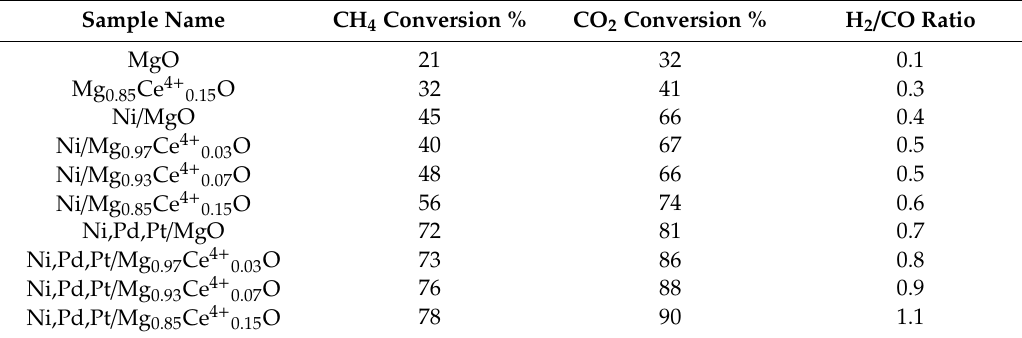
Table 4. The DRM reaction results of the catalysts at 900 ◦ C and a CH 4 :CO 2 ratio of 1:1 ratio with GHSV = 15,000 mL h − 1 g − 1